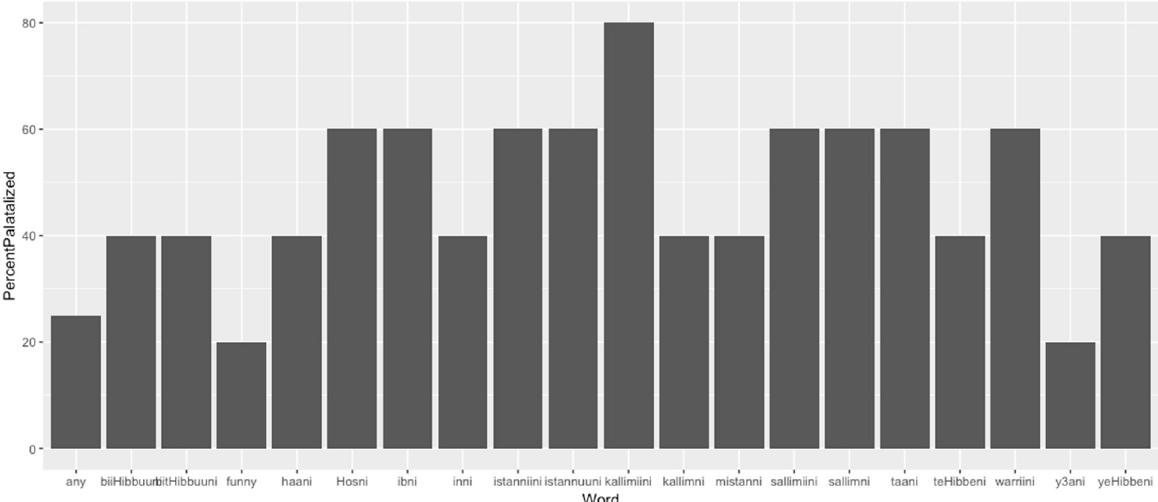
Figure 2. Visualization of proportion of palatalized tokens by word (based on Table 3).